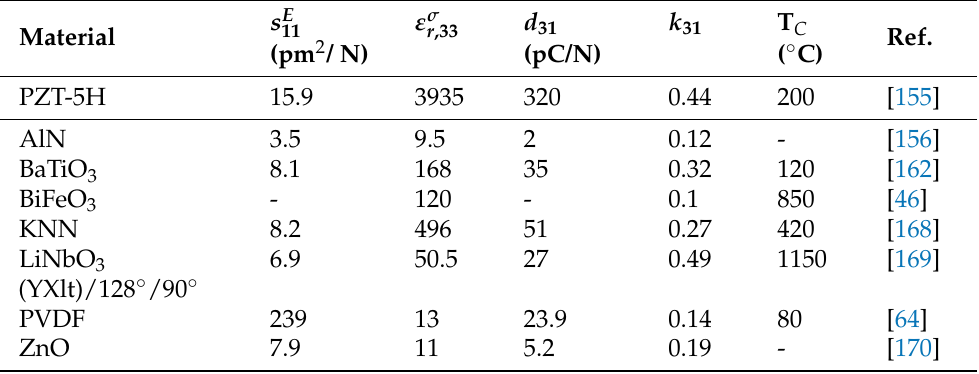
Table 2. Comparison of transverse electromechanical coupling k 31 of piezoelectric